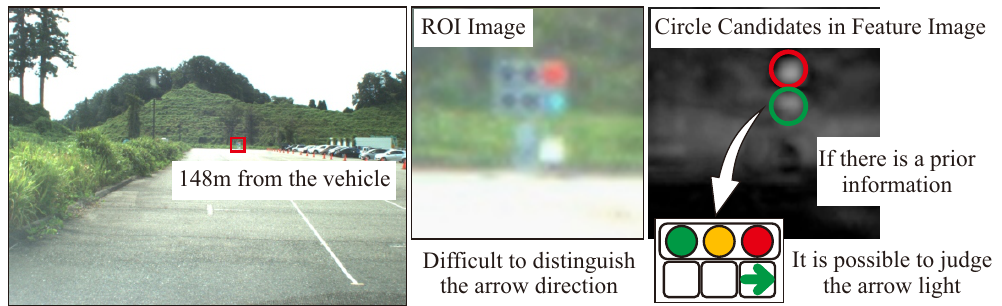
Figure 10. Arrow light recognition using prior information.